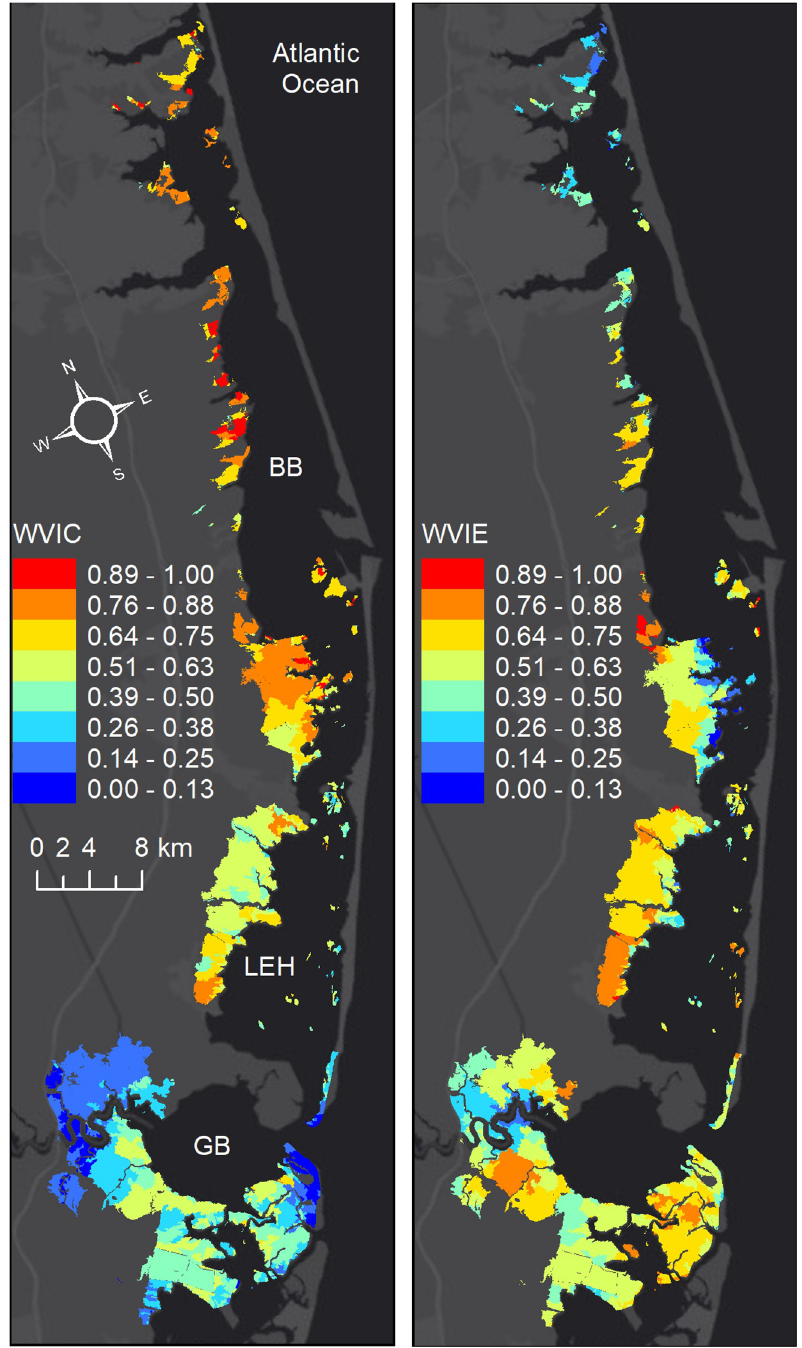
Fig 4. Chronic versus episodic wetland vulnerability index. a) Based on chronic indicators (WVIC; consisted of elevation, mean tidal range, shoreline change rate, UVVR, residence time vulnerability indicators), and b) based on episodic indicators (WVIE; consisted of change in sediment concentration, change in salinity and salinity exposure, marsh condition change, and exposure to contaminants vulnerability indicators).